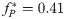
Species coexistence and optimal community function at an intermediate cost.Calculations were based on Eqs 6–10 with H and M’s growth parameters fixed at their respective evolutionary upper bounds (Table 1, “Preadapted”). (A) Stable species coexistence at moderate to low cost. Bottom: When fP, the fraction of potential growth Manufacturer diverts for making Product, is high (e.g., fP = 0.7), M will eventually go extinct (i.e., fraction of M < 1 ÷ BMtarget). Top: At moderate and low cost fP (e.g., fP = 0.4 and fP = 0.1), H and M can stably coexist. That is, different initial species ratios will converge to a steady-state value. At the end of the first cycle (time T = 17), Byproduct and Resource were reset to the initial conditions at time zero (0 and 104, respectively), and total biomass was reduced to the target value BMtarget = 100, while the fraction of M biomass ϕM remained the same as that of the parent community. See main text for how values of maturation time and Resource were chosen. (B) Optimal community function occurs at an intermediate cost fP. Community functions at various combinations of fP and fraction of M biomass (out of BMtarget = 100 total biomass) were computed by integrating Eqs 6–10. Maximal community function P(T) is achieved at an intermediate cost fP*=0.41 (magenta dashed line) when Newborn species composition is also optimal (46 H and 54 M cells). Note that, at zero fP, no Product would be made; at fP = 1, M would go extinct. The maximal P*(T) could not be further improved even if we allowed all growth parameters and fP to mutate (S10 Fig). Thus, P*(T) is locally maximal in the sense that small deviation will always reduce P(T). Ancestral fP (gray) is lower than fP*. The central question is this: can intercommunity selection improve ancestral fP to fP* despite intracommunity selection favoring lower fP? The Matlab code can be found in S1 Code. H, Helper; M, Manufacturer.